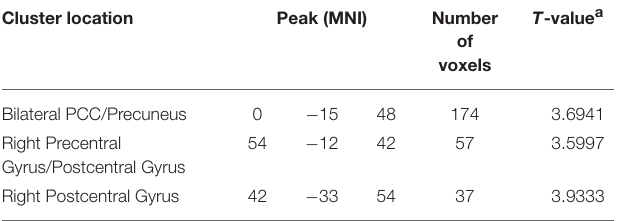
T -value a Cluster of voxels